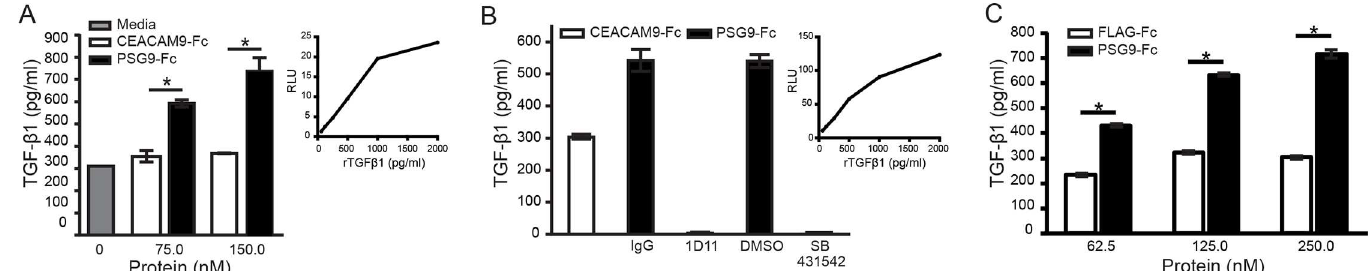
Fig 3. PSG9-Fc activatesthe SLC of TGF- β . (A) PSG9-Fc or control protein CEACAM9-Fc were incubatedat the indicatedconcentrations with 50ng/mLof the SLC of TGF- β 1 in DMEM-0.1% ITS media and added to luciferasereporter cells (MLEC). Media containing the SLC of TGF- β 1 in absenceof protein was used as a control and designated as medium.The level of mature TGF- β 1 in treated MLECs was estimated based on luciferase activity (RLU: relative light units) and is expressedas pg/ml of TGF- β 1 followingconversionof RLU using rTGF- β 1 to generatea standardcurve as shown. (B) PSG9-Fc or control protein CEACAM9-Fc were incubatedwith SLC as indicatedin A. Prior to incubationwith MLECs, 60 μ g/ml of the pan TGF- β neutralizing1D11 mAb or 5 μ M of the TGF- β receptor I kinase inhibitorSB4315422or the indicatedcontrols were added to the mix. The standardcurve generated followingincubation of the cells with r TGF- β 1 for the conversion of RLU to pg/ml of TGF- β 1 is shown (C) PSG9-Fc or the control protein FLAG-Fc, were incubatedat increasing concentrations with 50 ng/mL of the SLC of TGF- β 1 for 1 h at 37 ˚ C. ELISA plate coated with anti- TGF- β 1 antibody was used to detect active TGF- β 1 levels in the samples as describedin Materials and Methods. Mean ± SEM values are shown and Student’s t -test was employedfor statistical analysis.All treatments were performed in triplicate wells with one representative experiment of three independentrepeats shown.